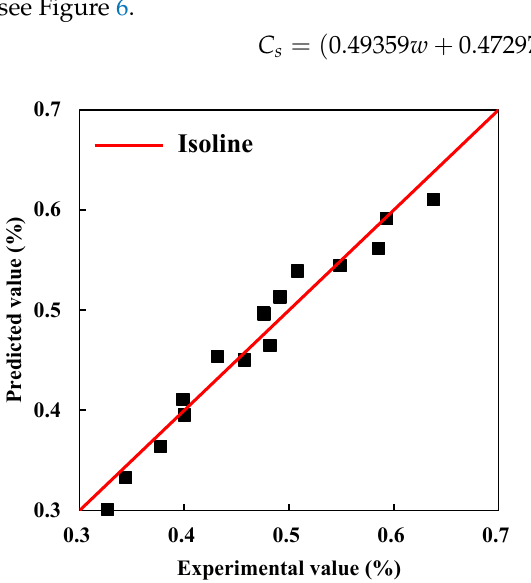
Figure 6. Predicted effect of surface chloride concentration.